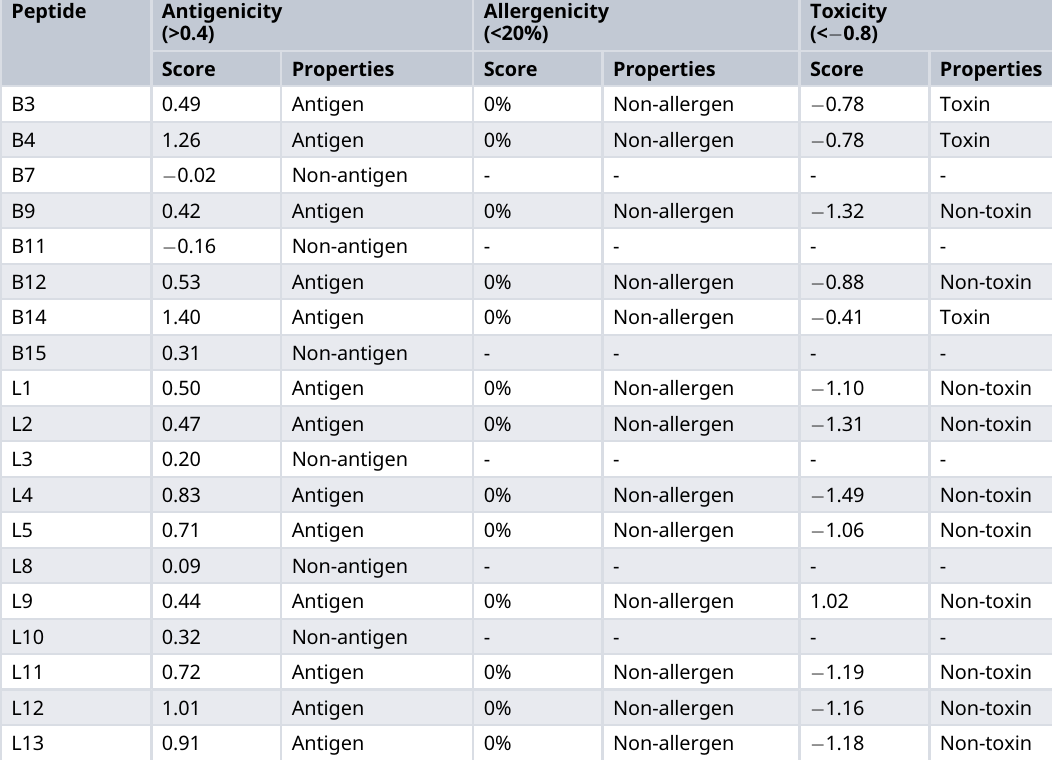
Table 3. Prediction results of SARS-CoV-2 vaccine candidate peptide properties.